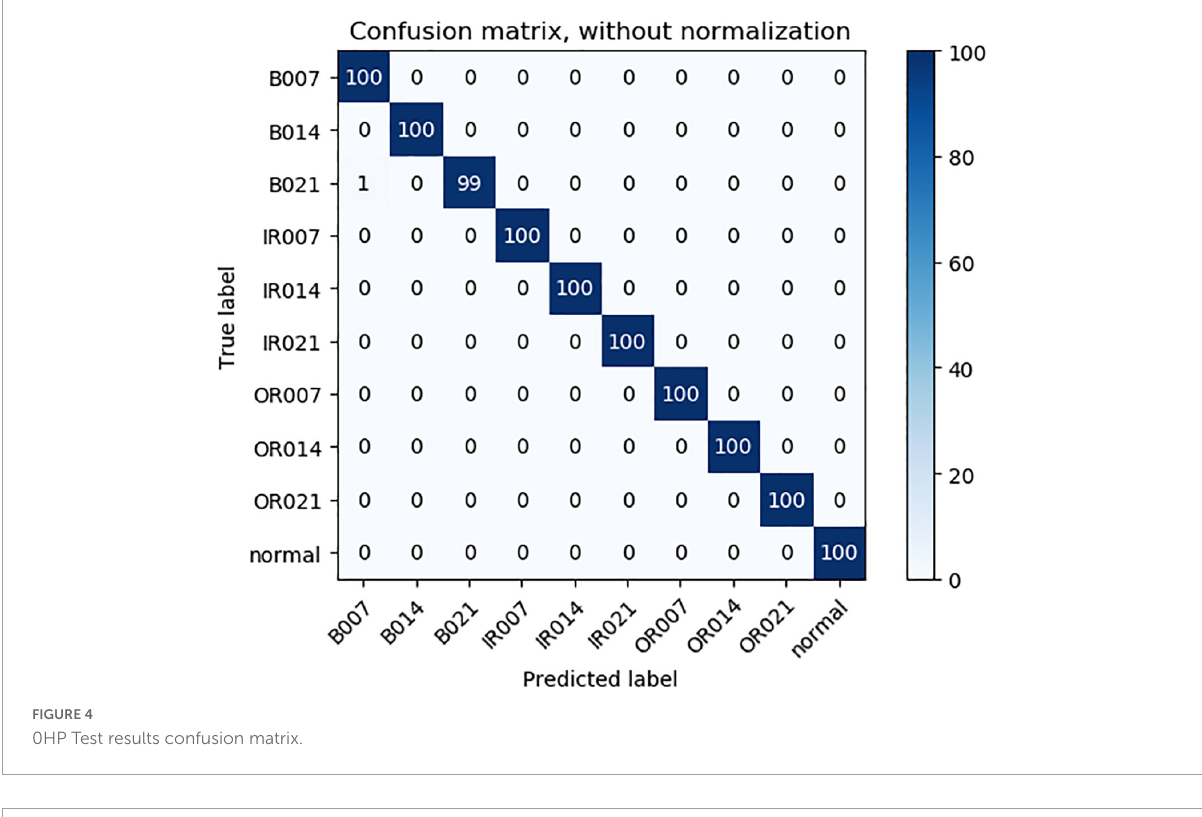
FIGURE4 0HP Test results confusion matrix.